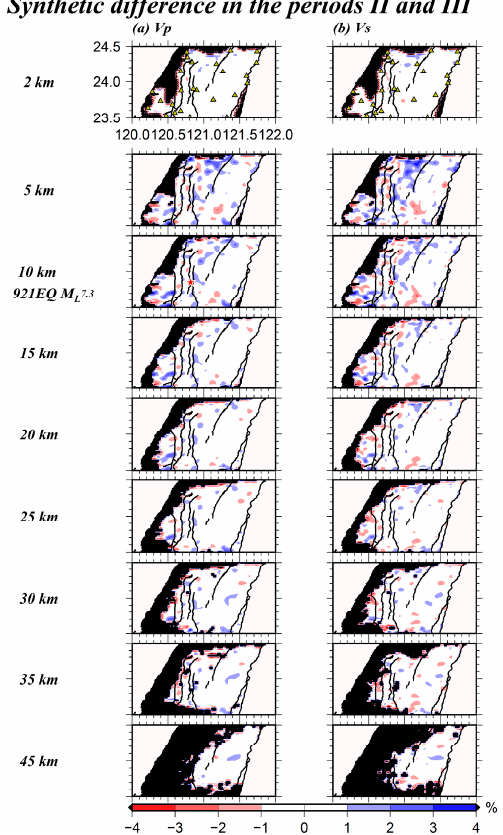
Figure 9. The synthetic difference model with unchanged synthetic model recovered using two data subsets. Yellow triangles represent the stations. ( a ) Synthetic difference of Vp in the periods II and III. ( b ) Synthetic difference of Vs in the periods II and III.